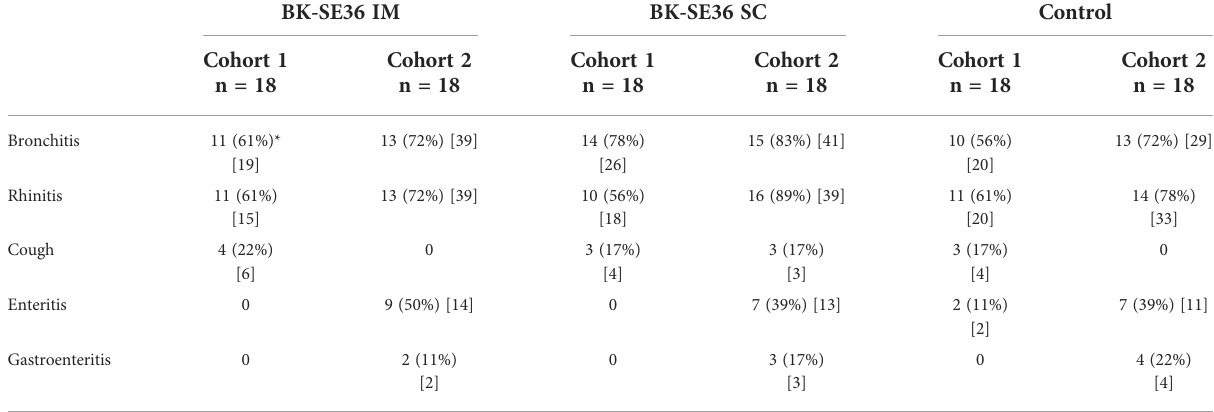
TABLE 3 Frequently reported adverse